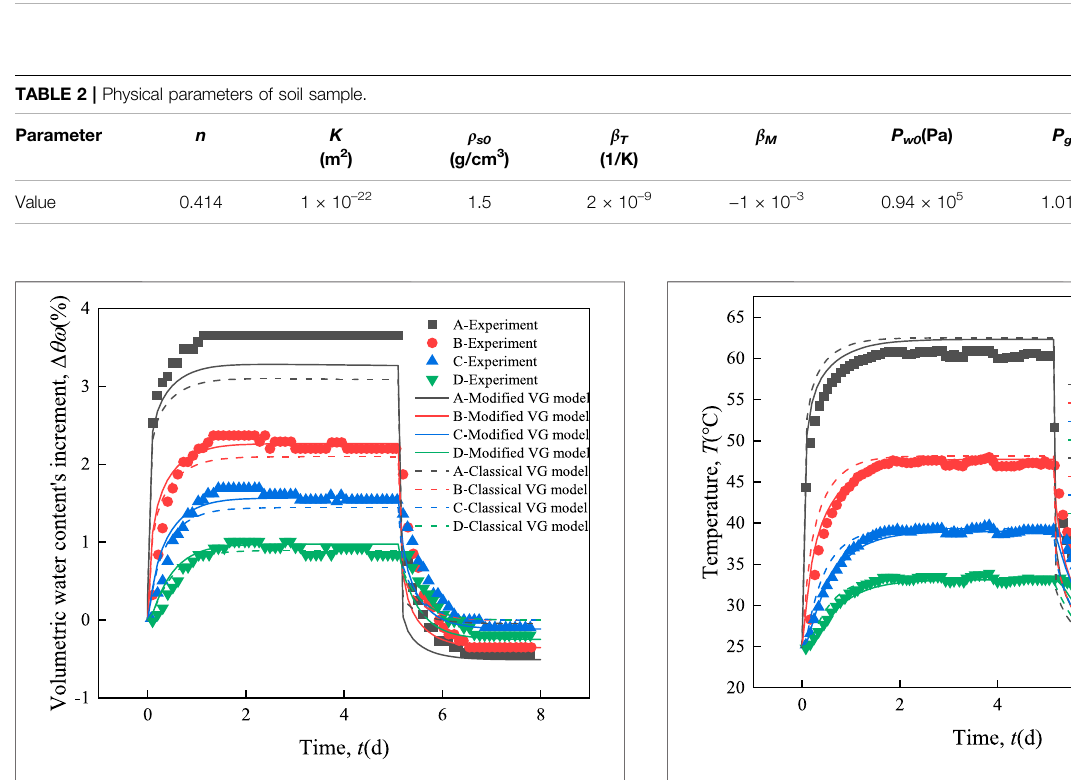
FIGURE 7 | Comparison of temperature test value and numerical